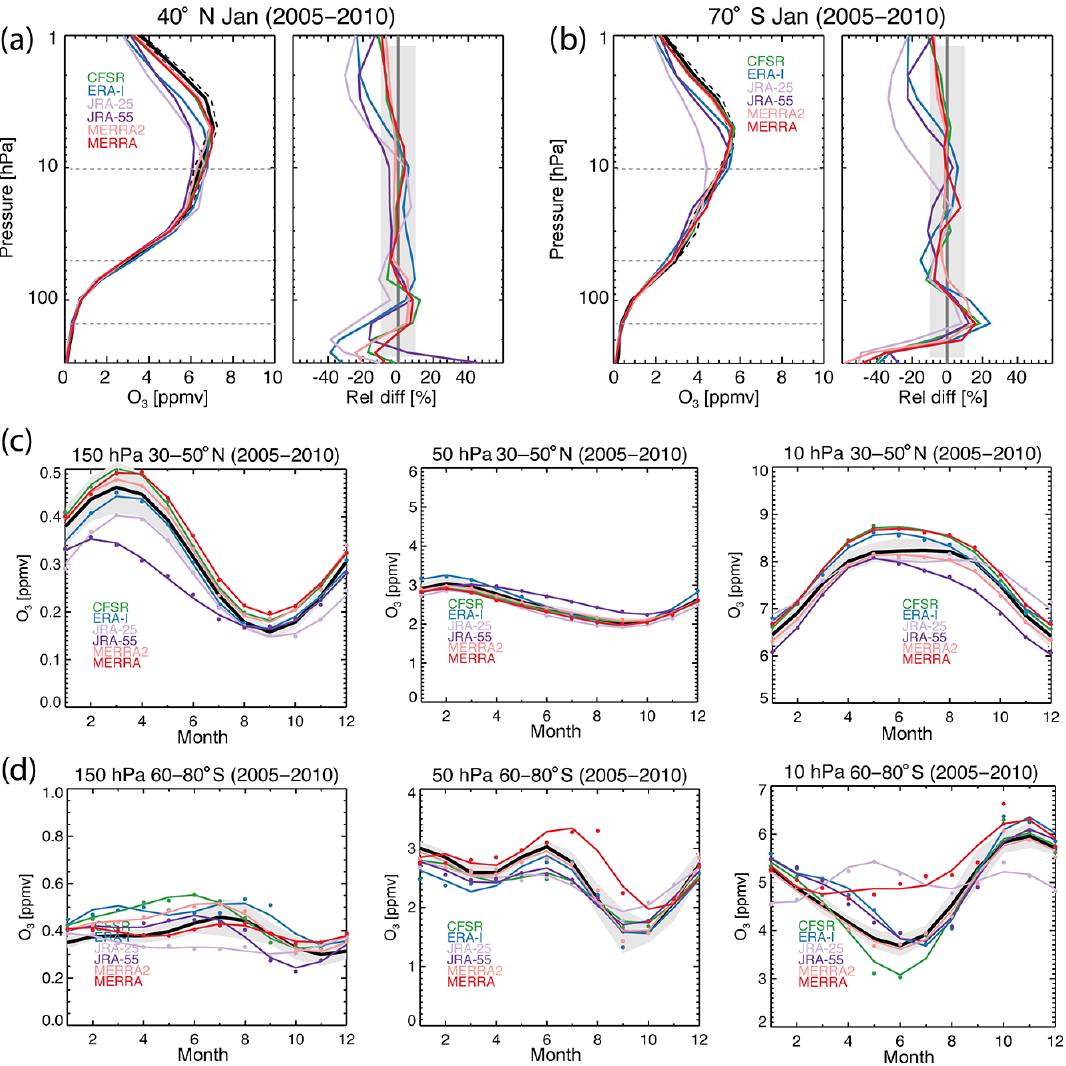
Figure 5. Multi-annual mean vertical ozone profiles over 2005–2010 for January at (a) 40 ◦ N and (b) 70 ◦ S from the SPARC Data Initiative multi-instrument mean (SDI MIM) (black) and the six reanalyses (colored). Absolute values are shown in the left panels and relative differ- ences in the right panels for each comparison. Relative differences are calculated as (R i − MIM )/ MIM · 100, where R i is a reanalysis profile. Black dashed lines provide the ± 1 σ uncertainty (as calculated by the SD over all instruments and years available) in the observational mean. Horizontal dashed lines in grey indicate the pressure levels (150, 50, and 10hPa) for which seasonal cycles are shown in panels (c, d) for the two latitude ranges 30–50 ◦ N and 60–80 ◦ S, respectively. In the lower panels, the SDI MIM uncertainty is shown using grey